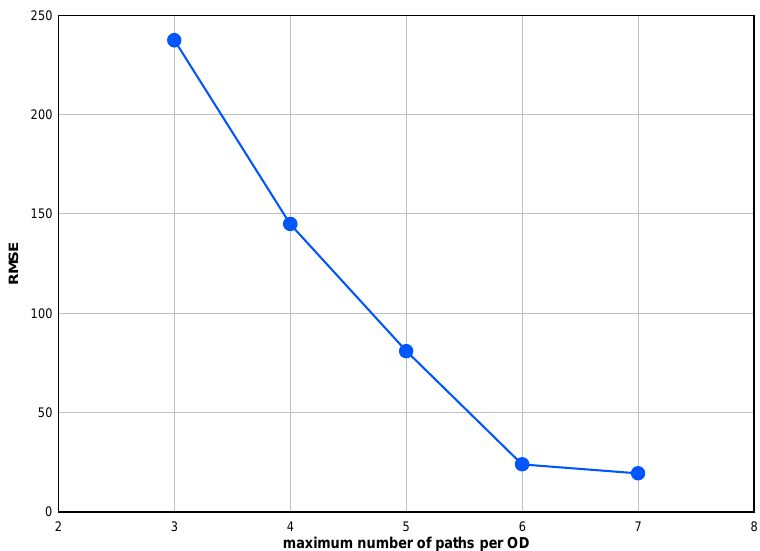
Figure 9. Variation of RMSE of link flows with the maximum number of paths per